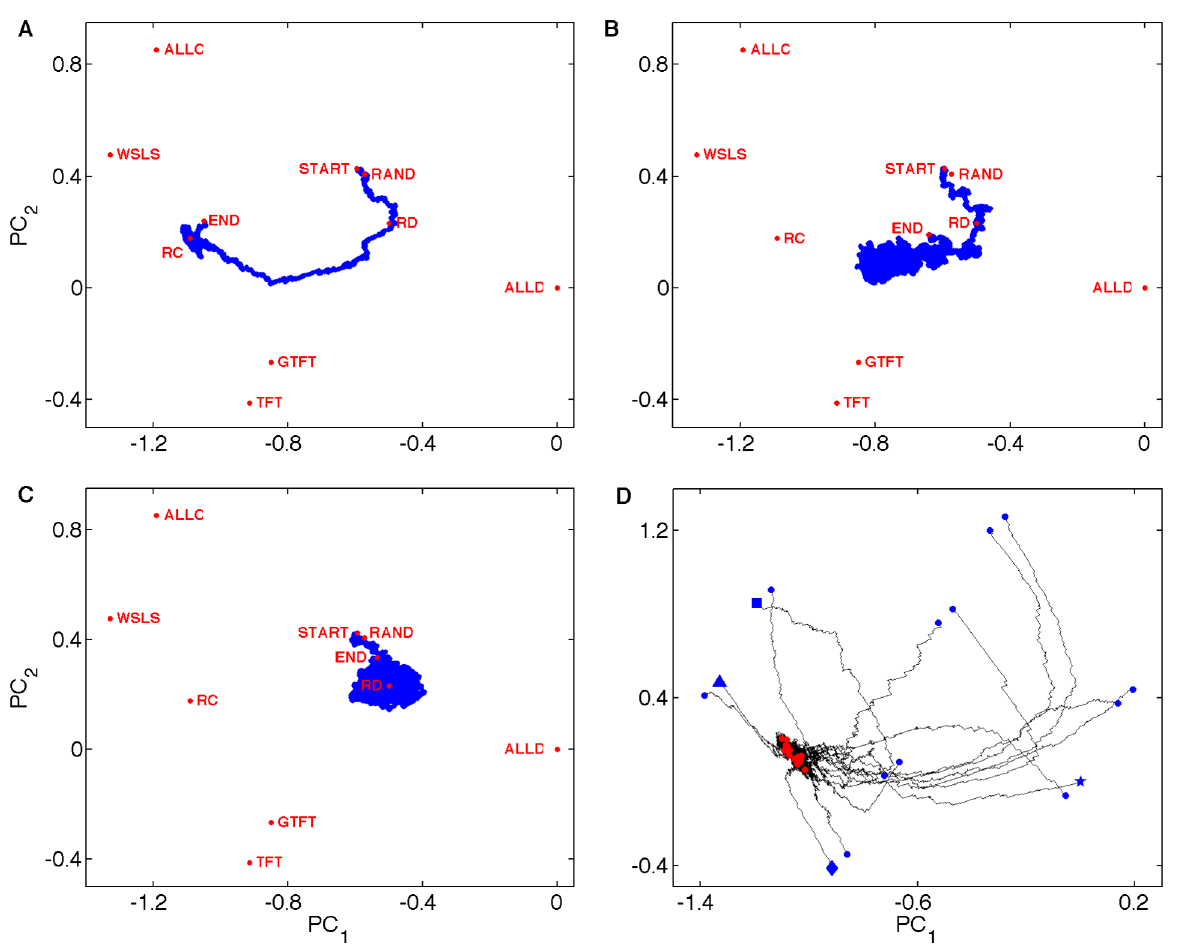
Figure 1. Evolutionary trajectories and attractors. All trajectories start at the same point (START), and move towards the strategy marked by ‘END’. Several well-known strategies provide landmarks in strategy space: TFT: ( P CC , P CD , P DC , P DD )=(1,0,1,0), ALLC=(1,1,1,1), ALLD=(0,0,0,0), WSLS=(1,0,0,1), GTFT=(1,0.333,1,0), START=(0.5,0.5,0.5,0.5). All experiments shown are run in a spatially-structured environment at replacement rate r =1%. Trajectories for well-mixed populations are shown in Fig. S3. ( A ) Evolution of the average LOD for m =0.5%. RC marks the consensus genotype (see Methods) of this trajectory, while RAND marks the consensus genotype at m =50%, when the population drifts neutrally. This attractor is not the same as ‘END’ because that genotype lies past the most recent common ancestor of the population. ( B ) Trajectory for m =2.5%, close to the critical mutation rate. ( C ) Trajectory for m =5%. ‘RD’ marks the consensus genotype for these parameters. ( D ) Trajectories emanating from 16 deterministic strategies (at m =0.5%) suggest that the fixed point is unique. Blue symbols: start, red dots: end points. Symbols: X : TFT, & : ALLC, w : ALLD, m : WSLS. A–D use principal components of trajectory shown in A .